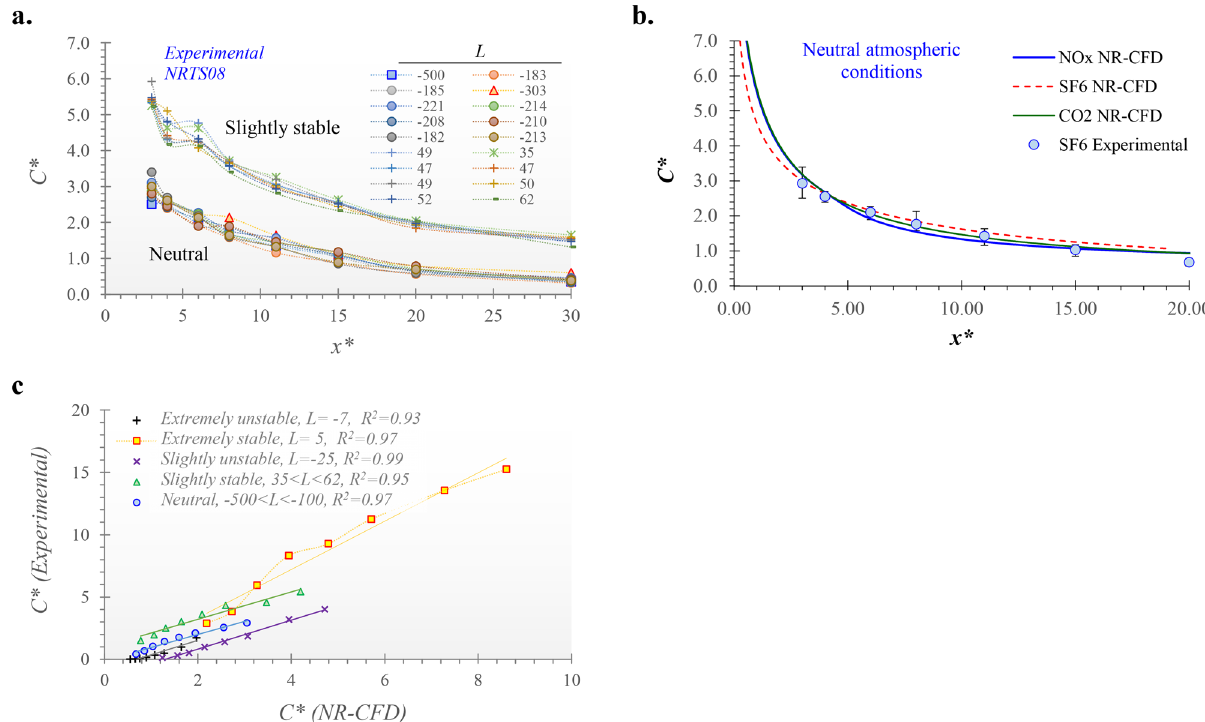
Figure 4. Comparison of NR-CFD results with experimental measurements obtained during the NRTS08 campaign under different atmospheric stability conditions 29 . ( a ) Experimental results obtained with SF6 under neutral and slightly stable conditions. ( b ) Comparison of SF 6 experimental results with the obtained by the NR-CFD model simulating the dispersion of SF 6 , NOx and CO 2 for the case of neutral atmospheric conditions. Vertical bars indicate the range of variation of experimental measurements. ( c ) Correlation analysis of experimental and NR-CFD